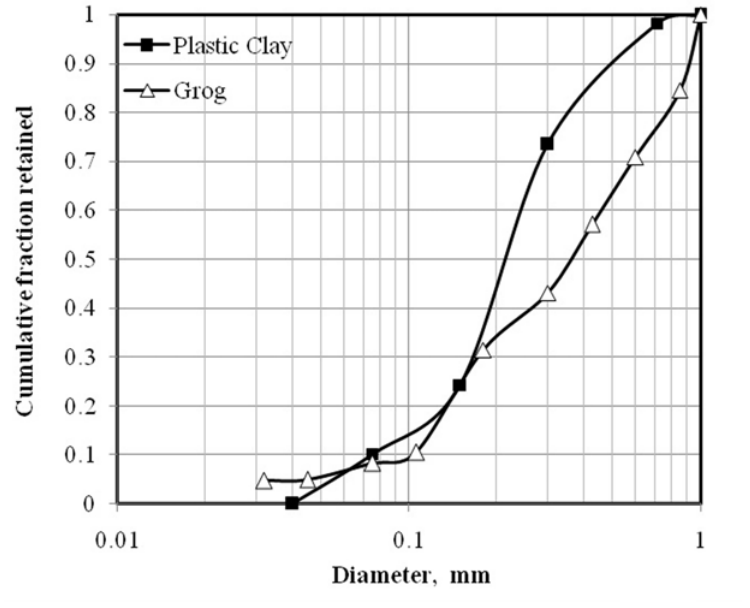
Figure 3. Particle size distribution of clay and grog